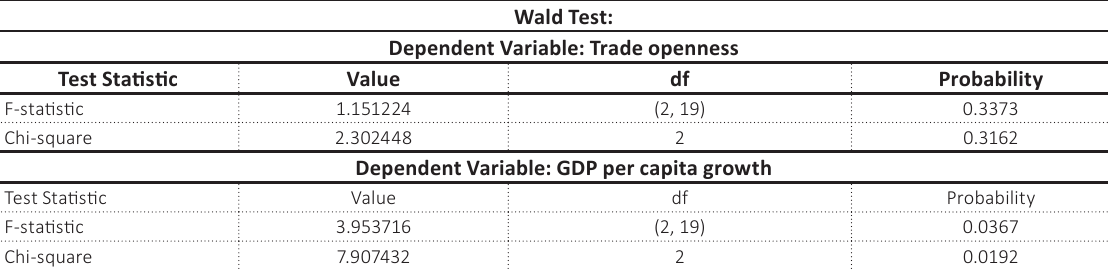
Table 3. Unrestricted VAR model